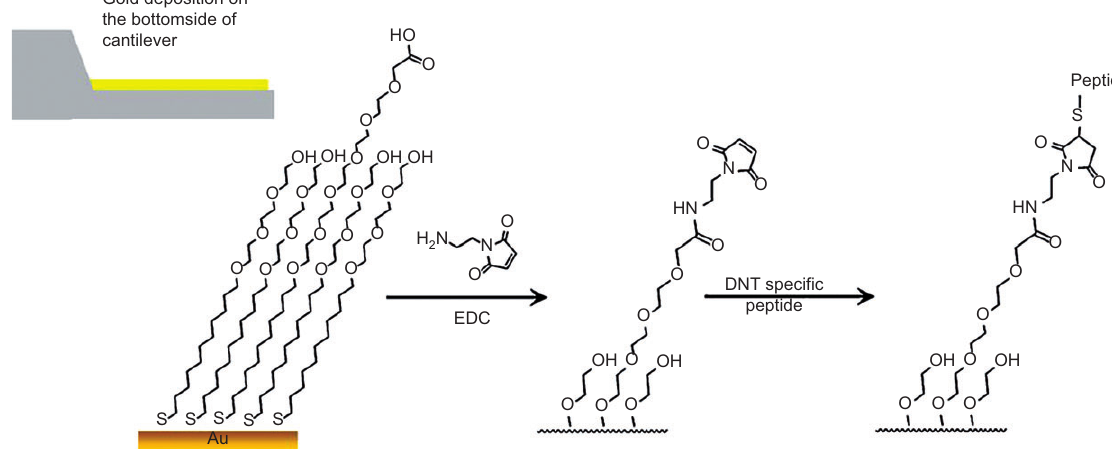
Figure 8 Schematic diagram of the surface functionalization process used to immobilize the DNT-specific peptides for gas phase DNT detection. Reproduced with permission from Hwang et al. (2011)